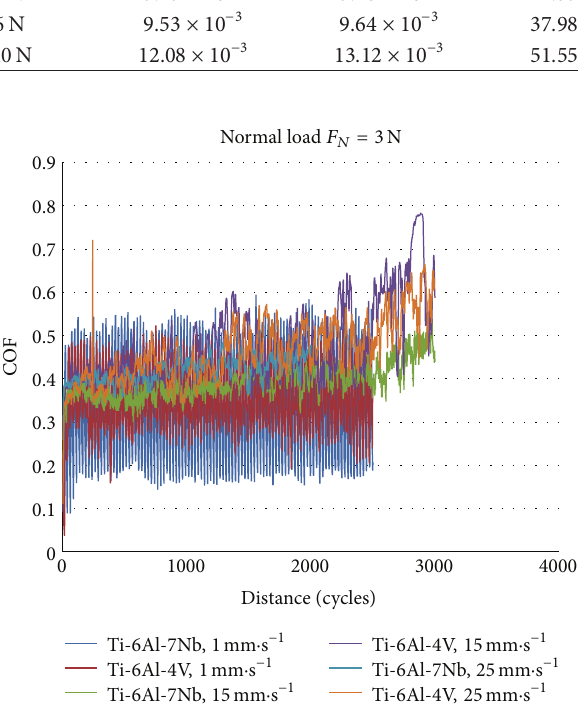
Figure 16: Friction coefficient of titanium alloys versus sliding distance under different sliding speeds at